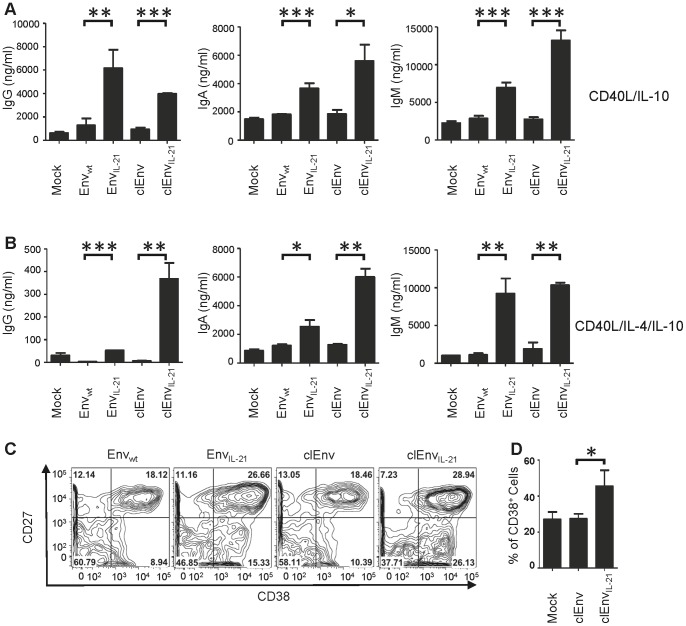
Immunoglobulin secretion from B cells cultured with Envwt, EnvIL-21, clEnv and clEnvIL-21 molecules in the presence of (A) CD40L/IL-10 and (B) CD40L/IL-4/IL-10.Data are representative of two independent experiments using B cells from two different donor, each tested in duplicate. (C) The expression of cell surface markers CD38 and CD27 on B cells cultured with Envwt, EnvIL-21, clEnv and clEnvIL-21supernatants in medium supplemented with CD40L/IL-10. Data are representative of three independent experiments using B cells from three donors. (D) The expression of CD38 cell surface marker treated with different cleaved Env (clEnv) and cleaved EnvIL-21 (clEnvIL-21) constructs in CD40L/IL-10 milieu. Data are representative of six experiments using B cells from six donors.